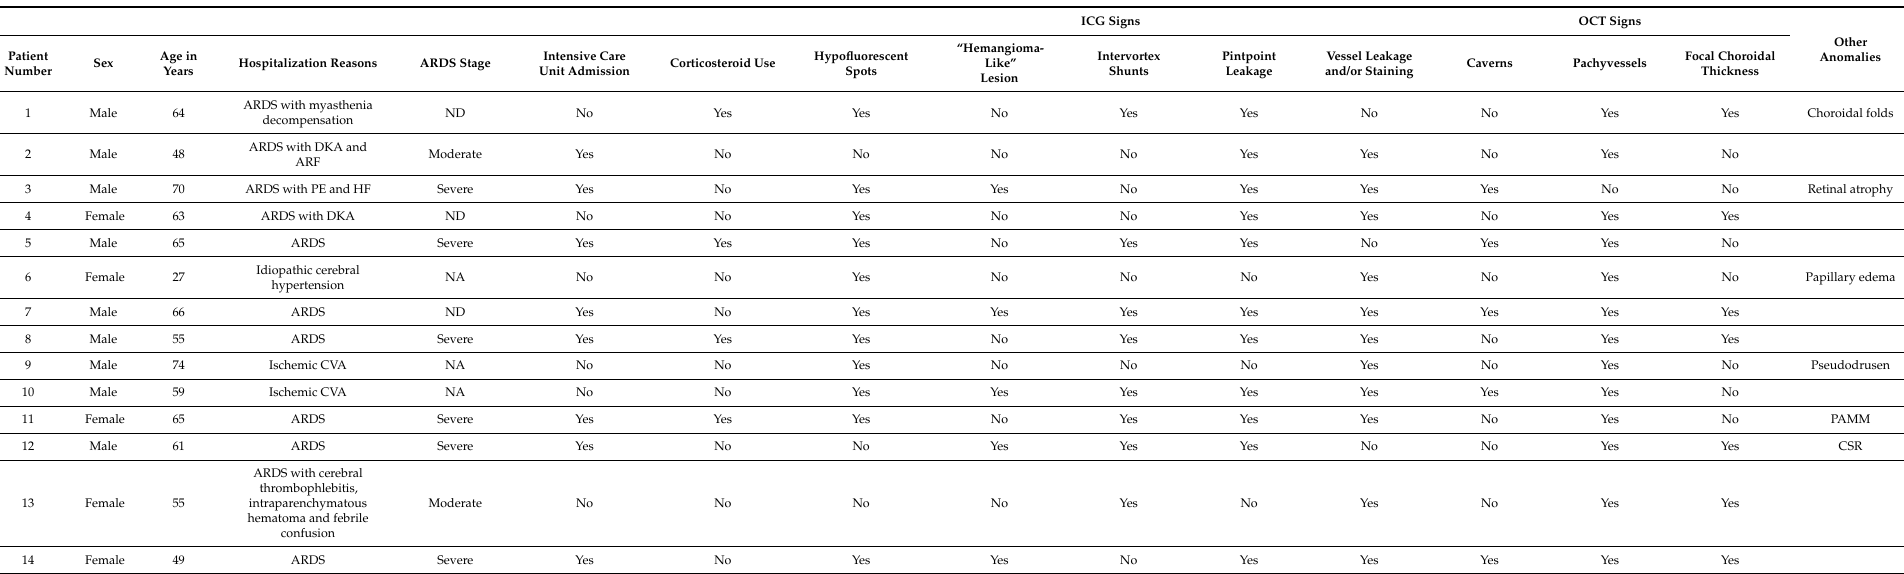
Table 3. Medical, indocyanine green angiography (ICGA) and optical coherence tomography (OCT) characteristics of each patient. ARDS: acute respiratory distress syndrome; ARF: acute renal failure; CSR: central serous retinopathy; CVA: cerebrovascular accident; DKA: diabetic ketoacidosis; HF: heart failure; NA: not applicable; ND: not determined; PAMM: paracentral acute middle maculopathy; PE: pulmonary